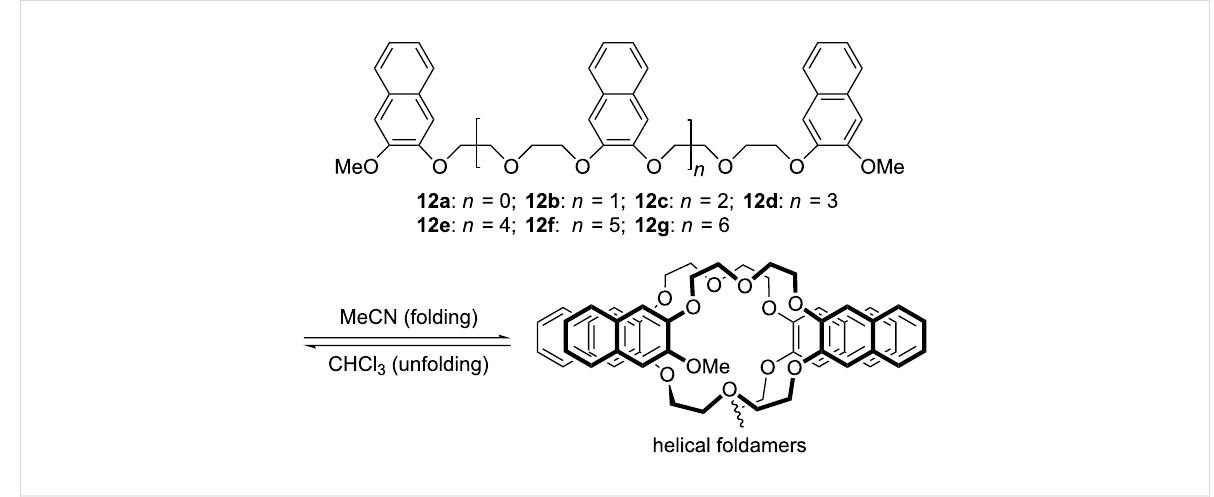
Scheme 6: The structures of compounds 12a–g and the formation of the helical conformation by the longer oligomers.